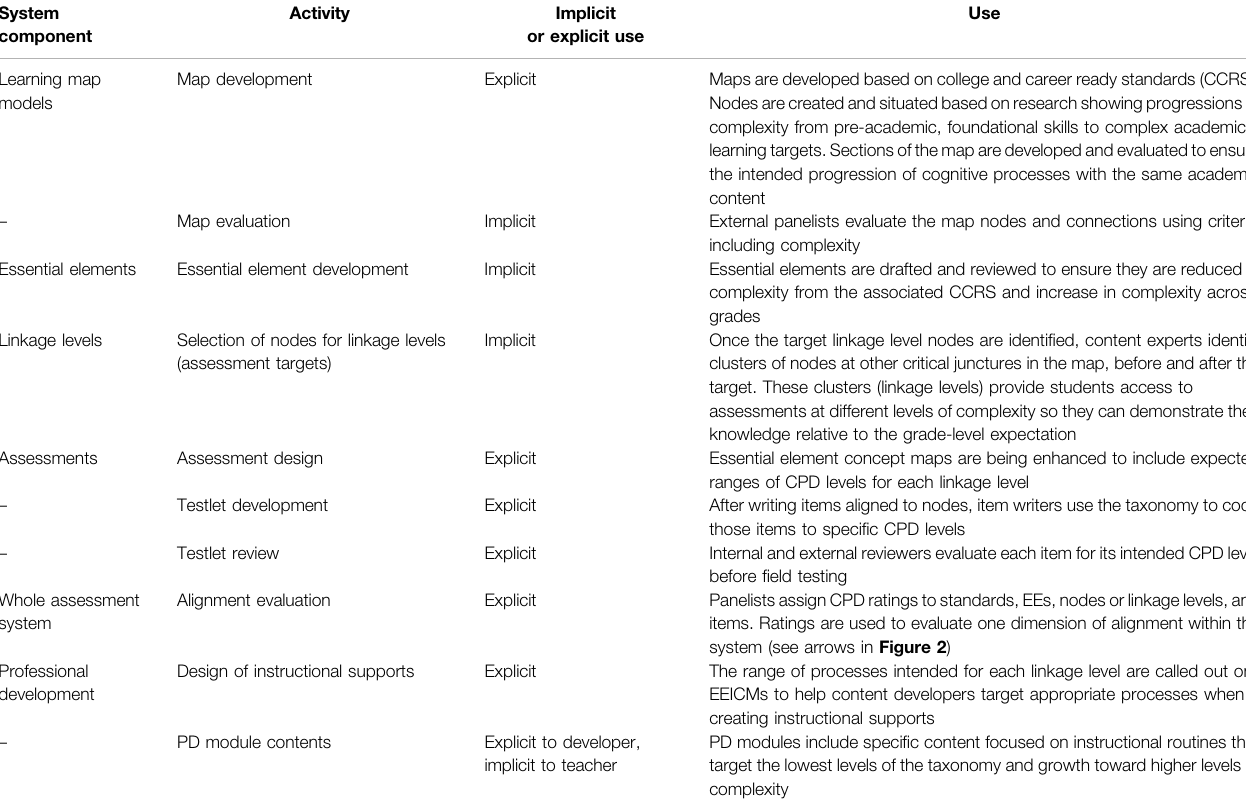
TABLE 3 | Uses of the DLM CPD taxonomy in the DLM alternate assessment